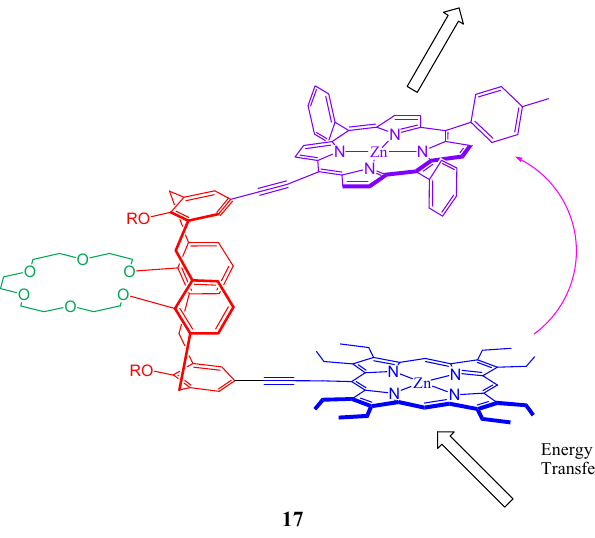
Figure 18. Possible photoinduced energy transfer observed in the tweezer molecular system ( 17 ) containing porphyrins, calixerene and crown